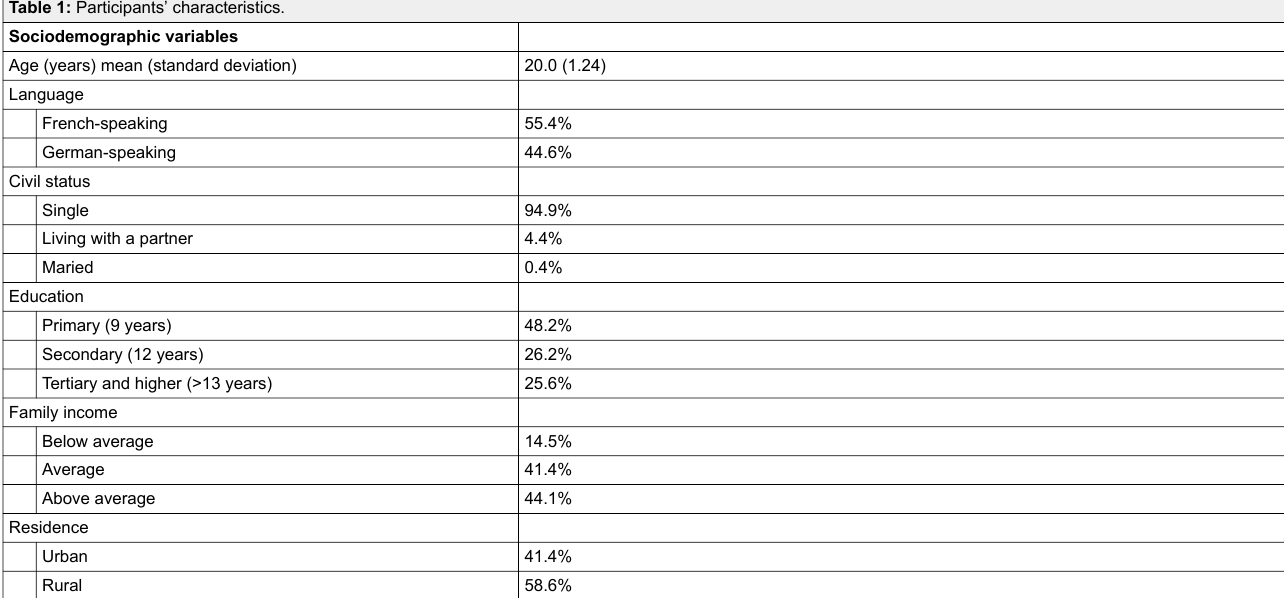
Table 1: Participants’ characteristics. Sociodemographic